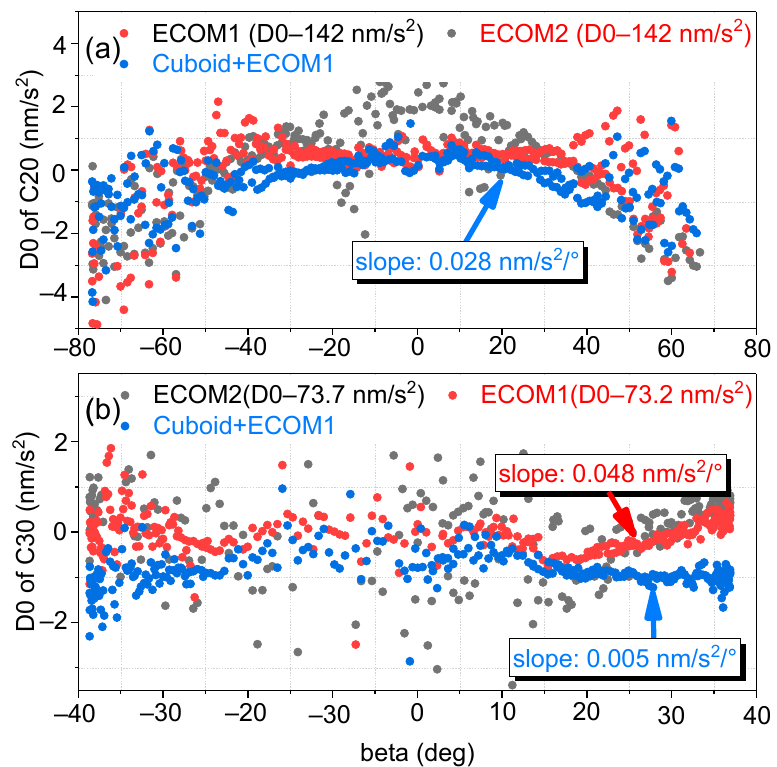
Figure 6. Estimations of the D0 parameters. The black, red, and blue dots are for the empirical ECOM2, ECOM1, and Cuboid + ECOM1 models, separately. The top figure ( a ) is for C20, and the bottom figure ( b ) is for C30.